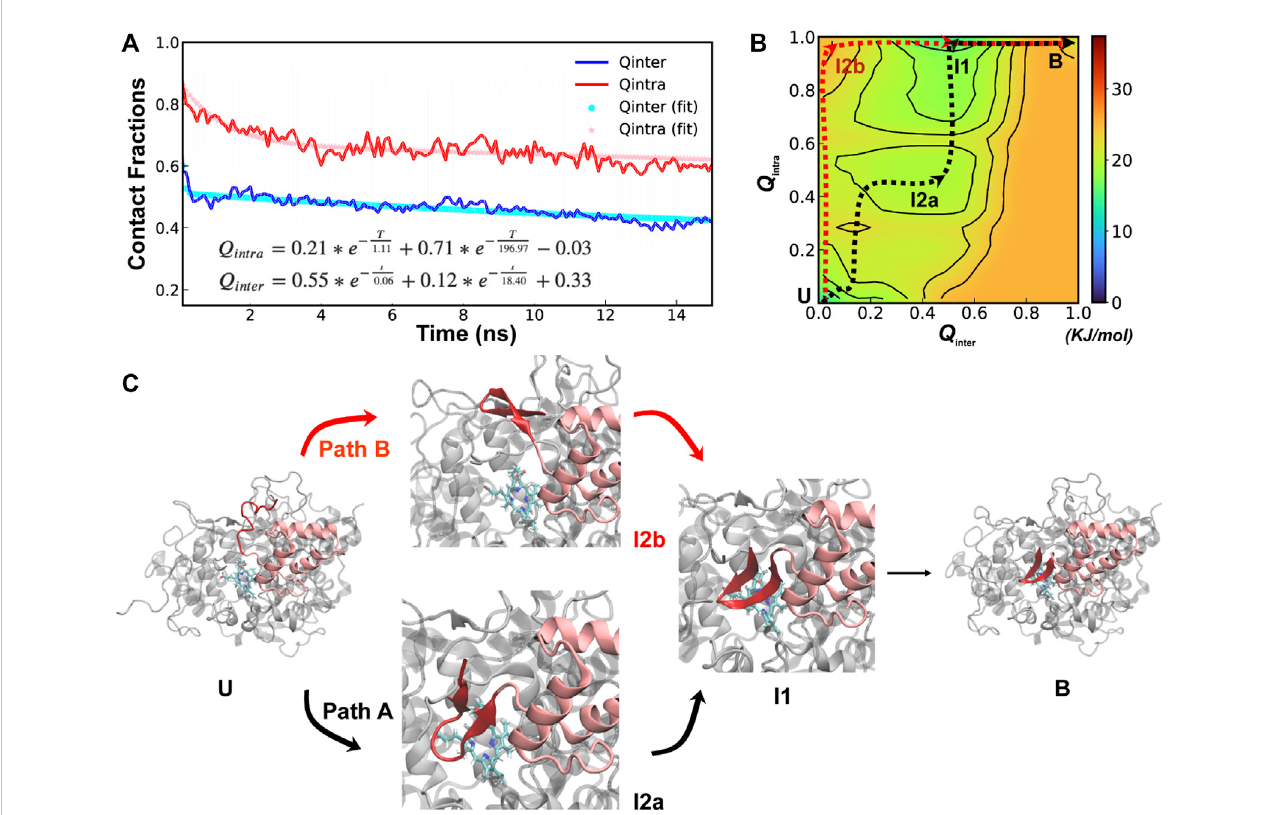
FIGURE 4 Cooperative binding and folding of SPIN- delphini . (A) Average intramolecular and intermolecular native contact fractions ( Q inter and Q intra ) as a function ofsimulation timeat450 K.The doubleexponential fi tsareplotusing dottedlines, withtheactualparametersalso shown. (B) Pseudofreeenergysurfaceasa function of Q inter and Q intra derived from the transition paths (see Methods). The dashed lines indicate the minimum free energy pathways, with key states labeled. (C) Two major parallel dissociation pathways and key intermediate states for coupled binding and folding of SPIN- delphini NTD to human MPO, with SPIN and MPO shown in red and light grey, respectively.